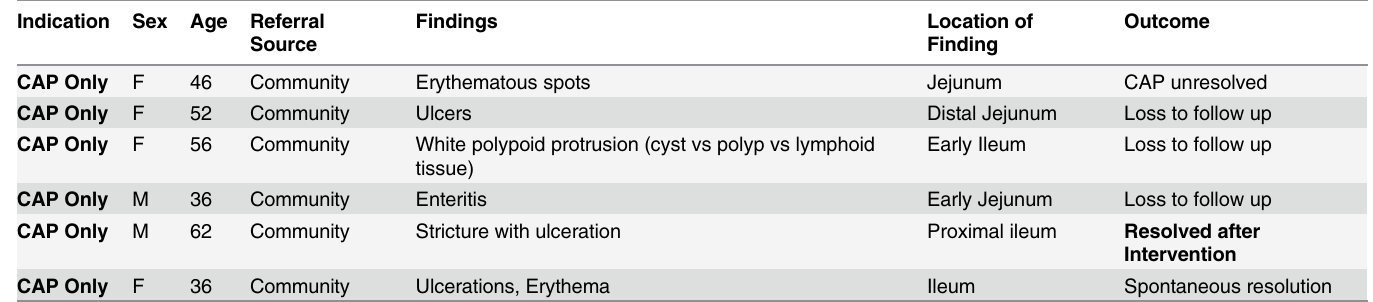
Table 5. Abnormal findings and outcomes for chronic abdominal pain (without other